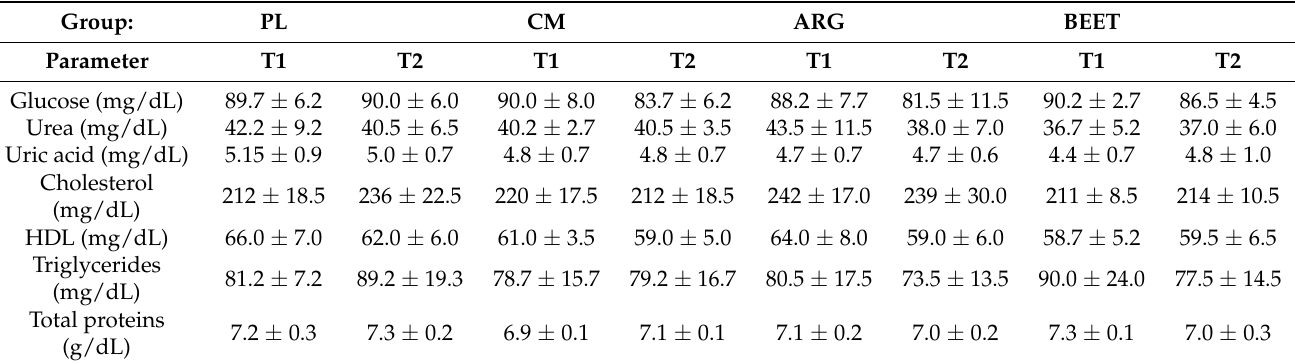
Table 2. Additional circulating